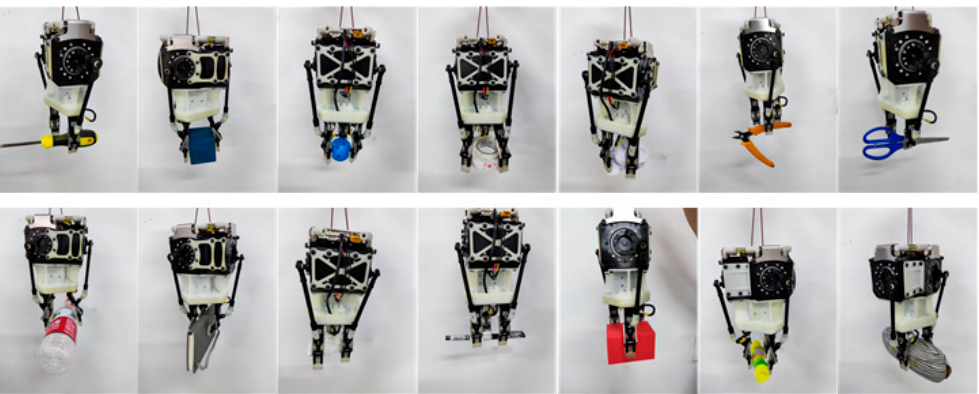
Figure 13. Gripping objects of different shapes that are common in daily life.